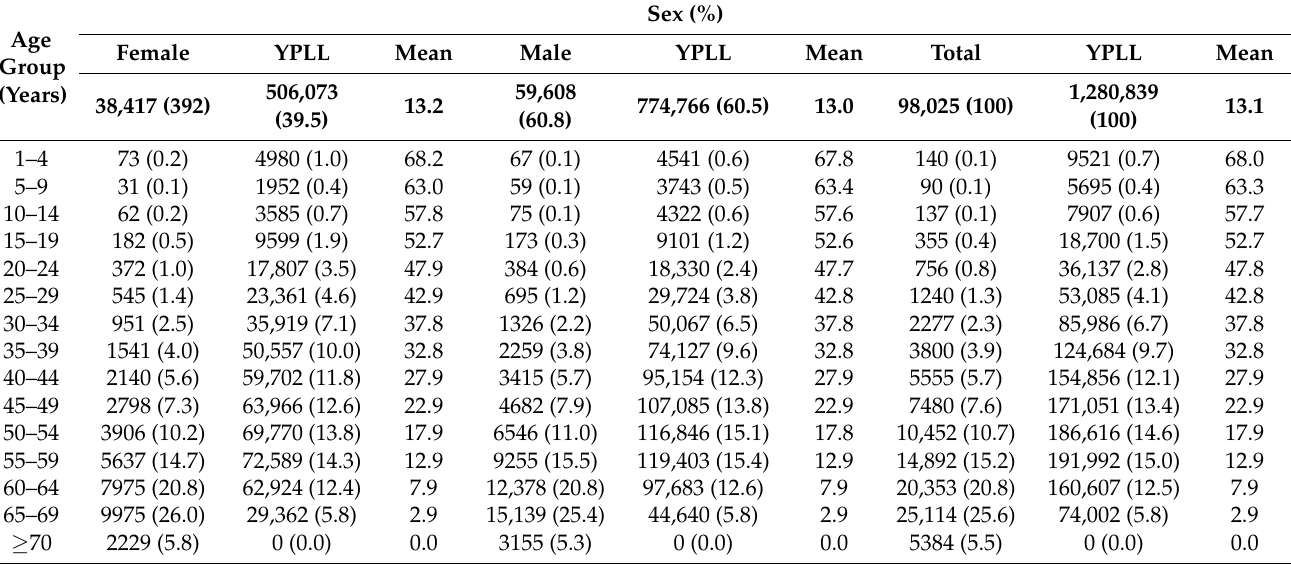
Table A3. Fatalities and years of potential life lost due to COVID-19 in Brazil (2020) by gender and age